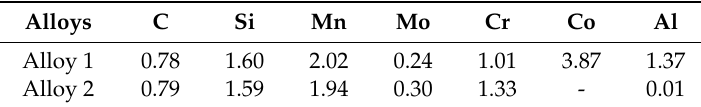
Table 1. Chemical composition of the tested steels (wt%).